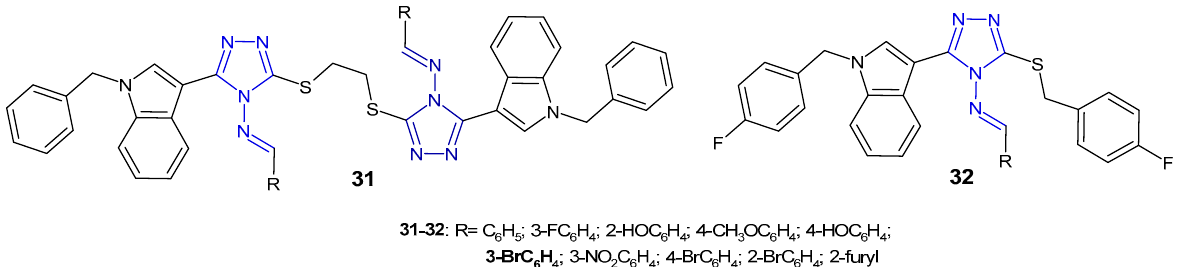
Figure 12. Antibacterial Schiff bases of 1,2,4-triazole – continued. Ünver et al. (2016) developed a series of hybrid 1,2,4-triazole molecules 33 – 34 (Figure 13) derived from Schiff and Mannich bases, and evaluated them for antibacterial activity against a panel of bacteria, namely E. coli , Y. pseudotuberculosis , P. aeruginosa , E. faecalis , S. aureus , B. cereus and Mycobacterium smegmatis . Among the new compounds, the Schiff base 33d carrying nitro substituent on the thiophene ring at the 4-position of 1,2,4-triazole showed the highest inhibitory activity against all tested species, 2- or even 35-fold higher than ampicillin. Compounds with morpholine 34 were generally less active